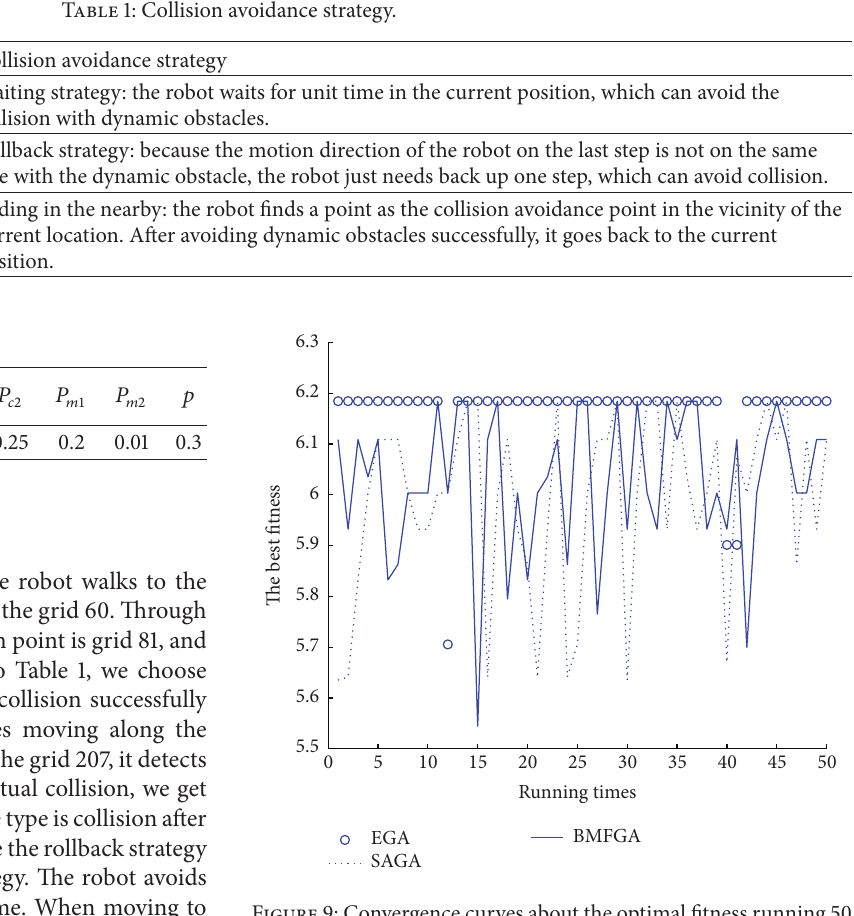
Figure 9: Convergence curves about the optimal fitness running 50 times.